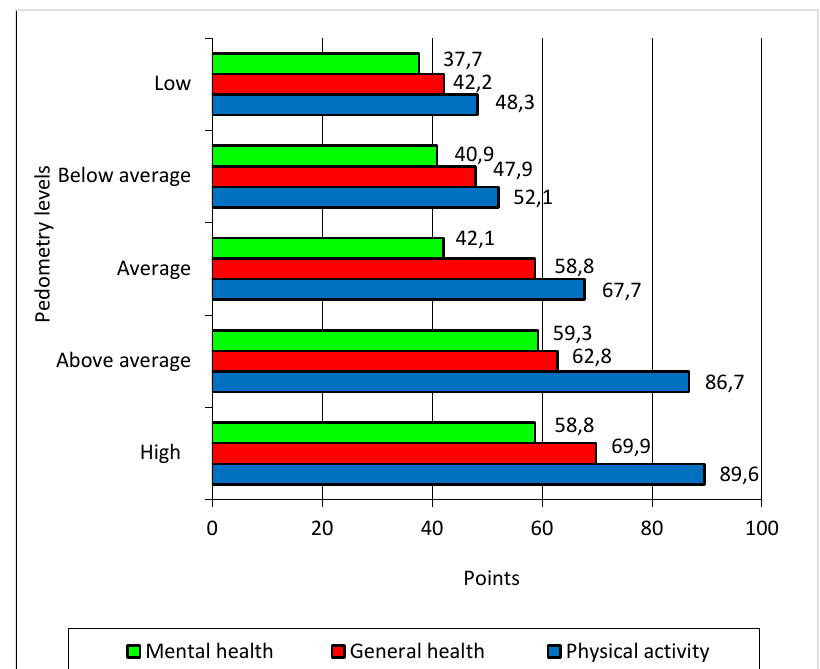
Figure 4. Life quality components of males with different levels of pedometry (in